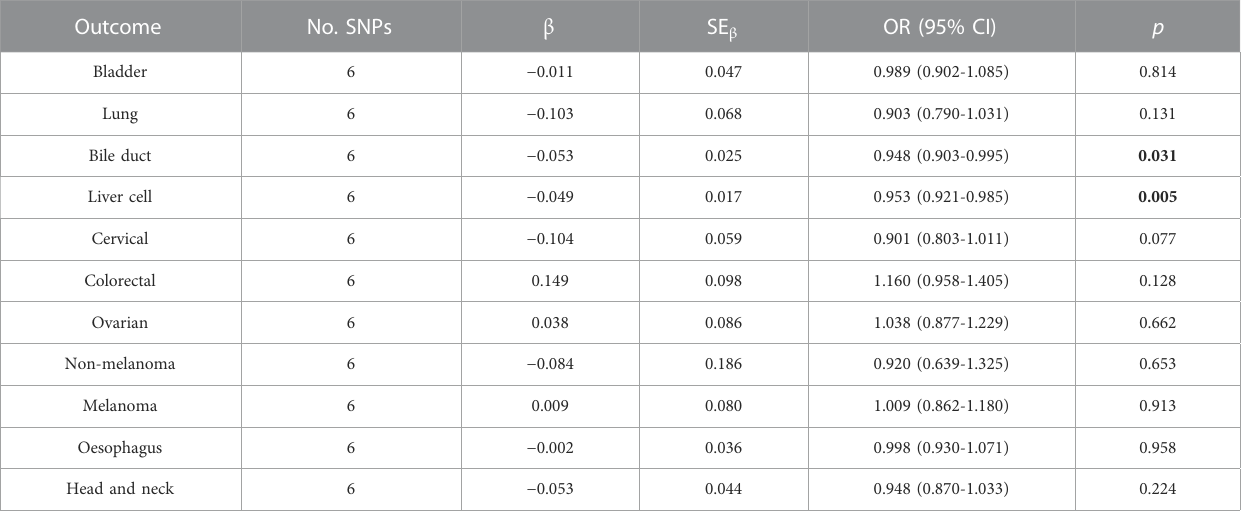
TABLE 4 Two sample MR analysis results of rosuvastatin use and pan-cancer via Fixed-effect inverse variance weighted (IVW EF ) method. Outcome No.